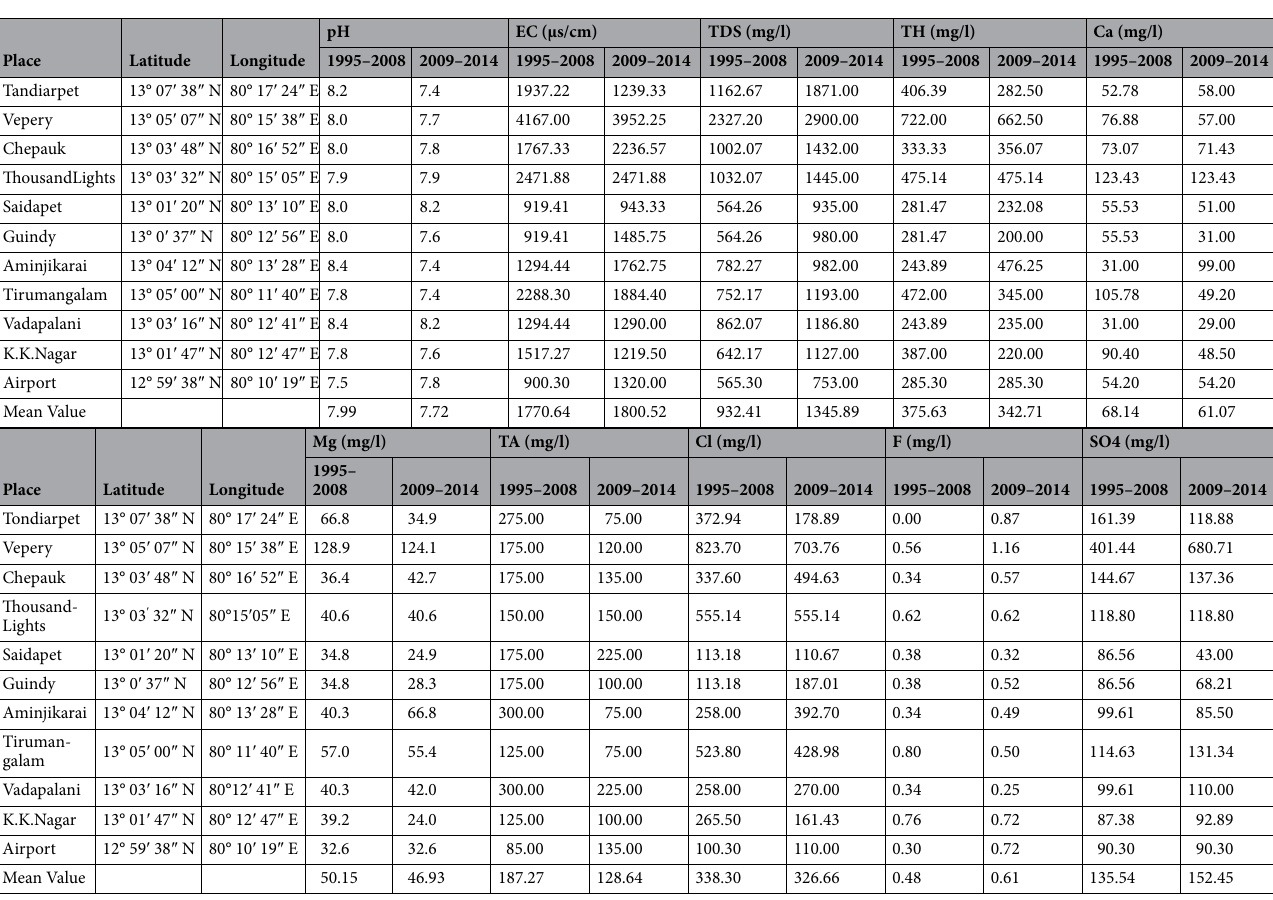
Table 2. Water quality parameters comparison for the two